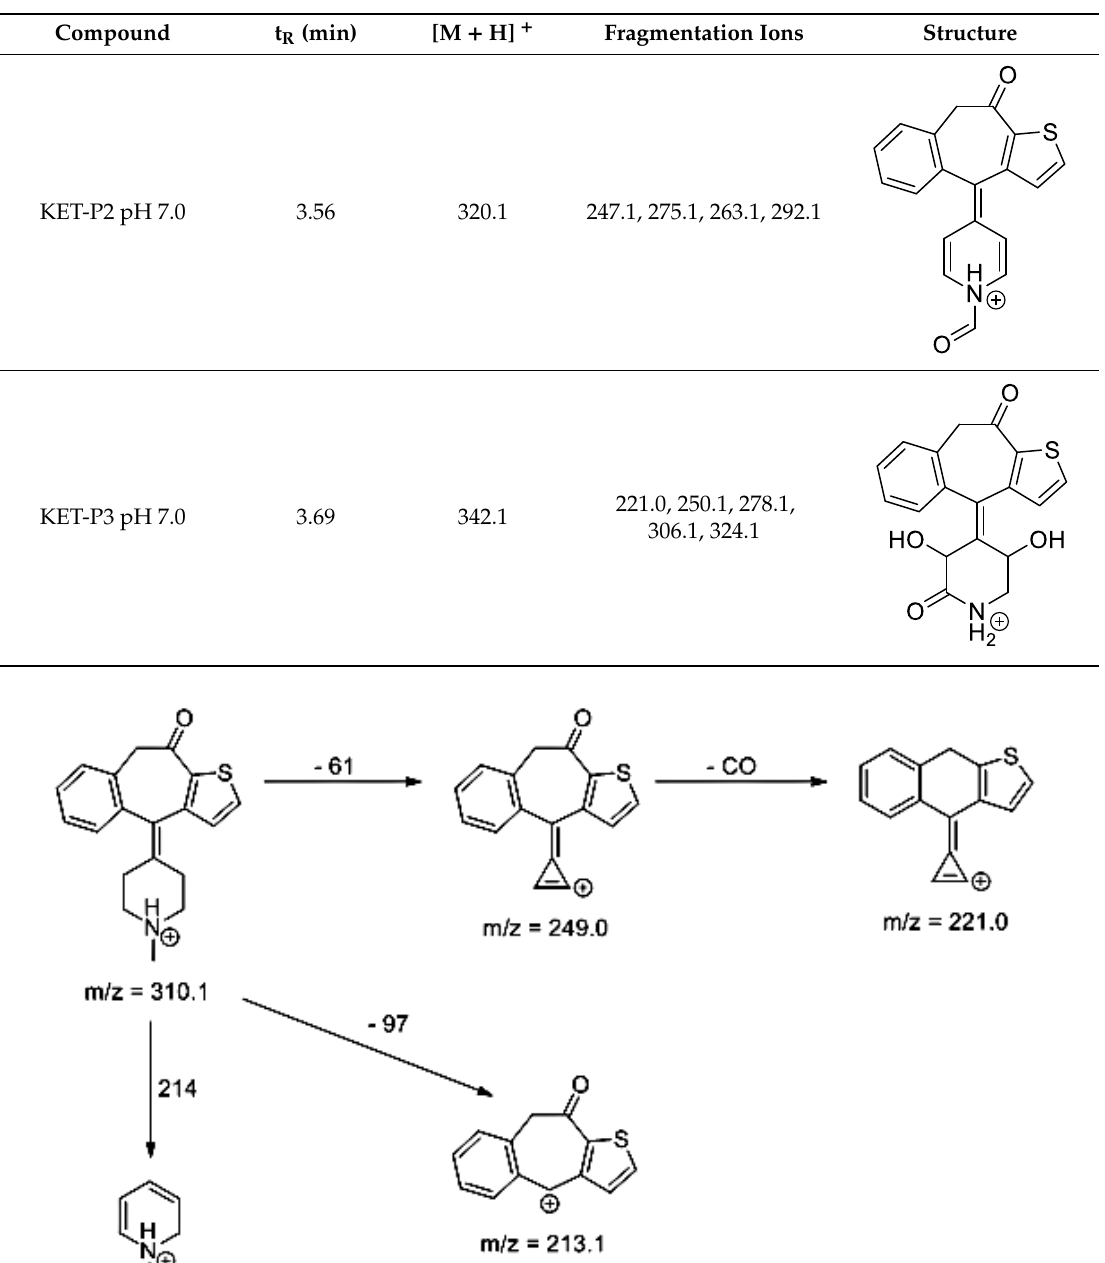
Figure 10. Proposed fragmentation pattern of ketotifen (KET).